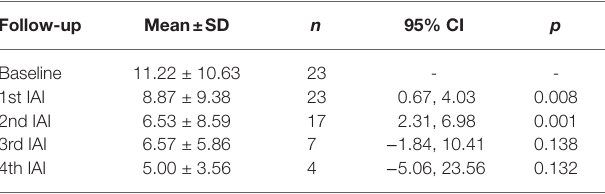
TABLE 6 | HRF before and after IAI in patients with